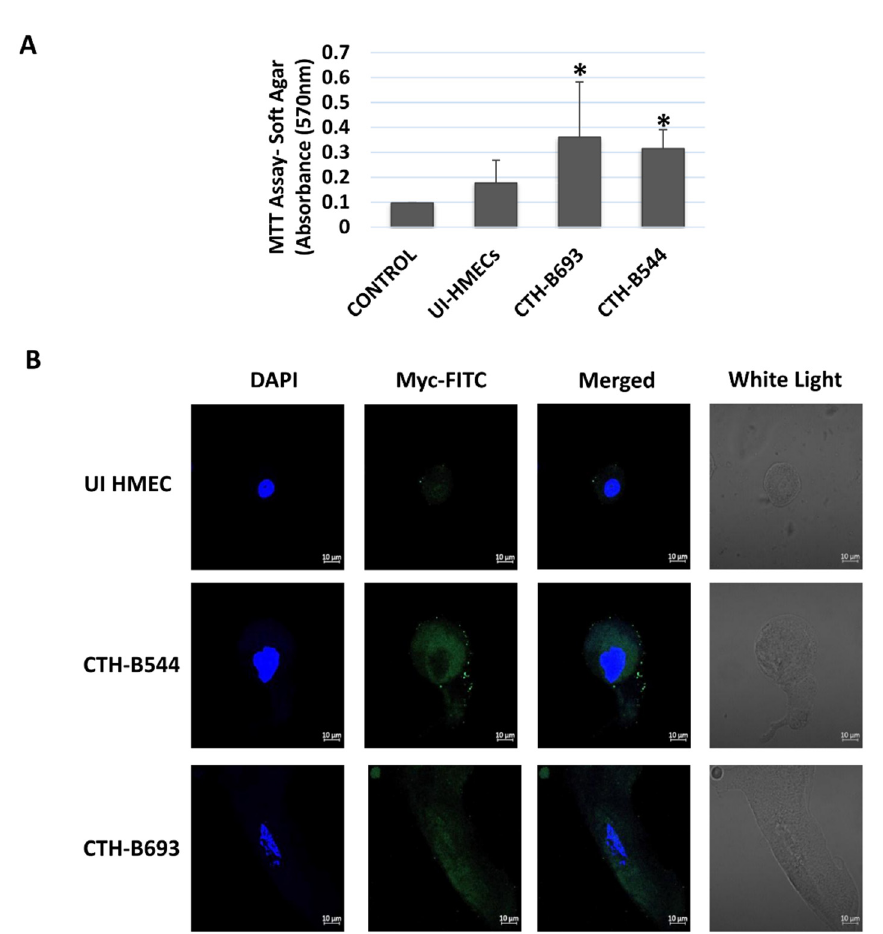
Figure 2. Colony formation in soft agar and Myc expression in CTH-B544 and B693 cells. ( A ) Colony formation in soft agar seeded with uninfected HMECs, CTH-B544 and CTH-B693 cells. At day 15 post-seeding, quantification of colonies was performed; Histogram represents the mean data ± SD of three independent experiments. * p -value ≤ 0.05, ( B ) Confocal microscopic images of Myc and DAPI staining in CTH cells. Magnification ×63, scale bar 10 μ m.